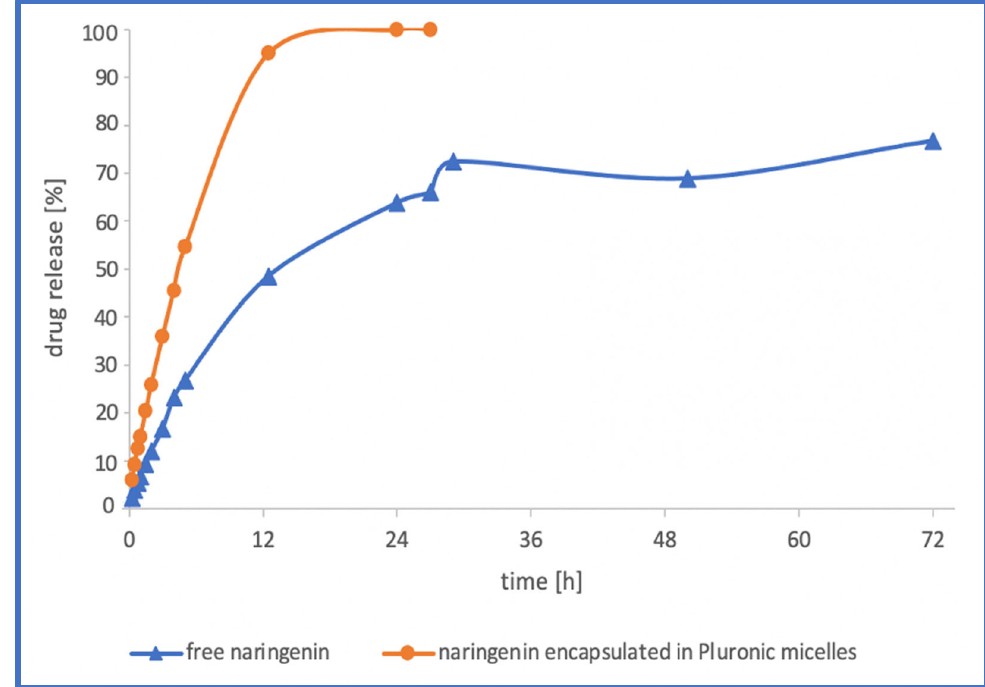
Figure 5. In vitro release profile of naringenin ‐ loaded P123/F127 Pluronic micelles (ratio 1:5) and free naringenin.